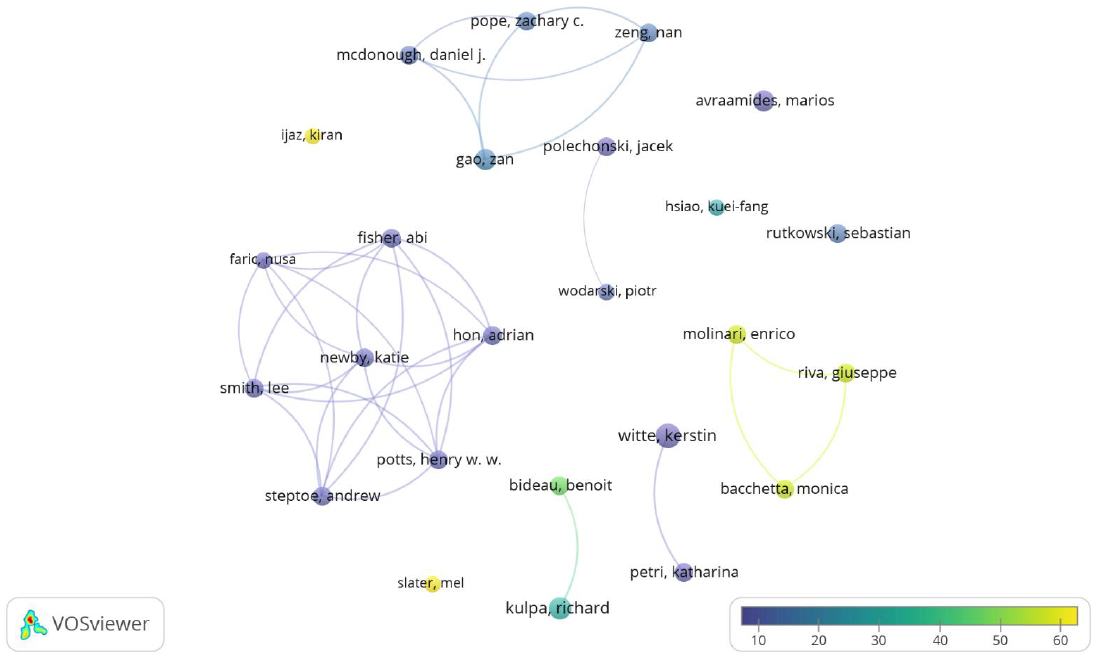
Figure 3. Prominent co-authors. Analysis: fractionalization, attraction: 10, repulsion: − 2, node size: document number, and colour: average citation number.